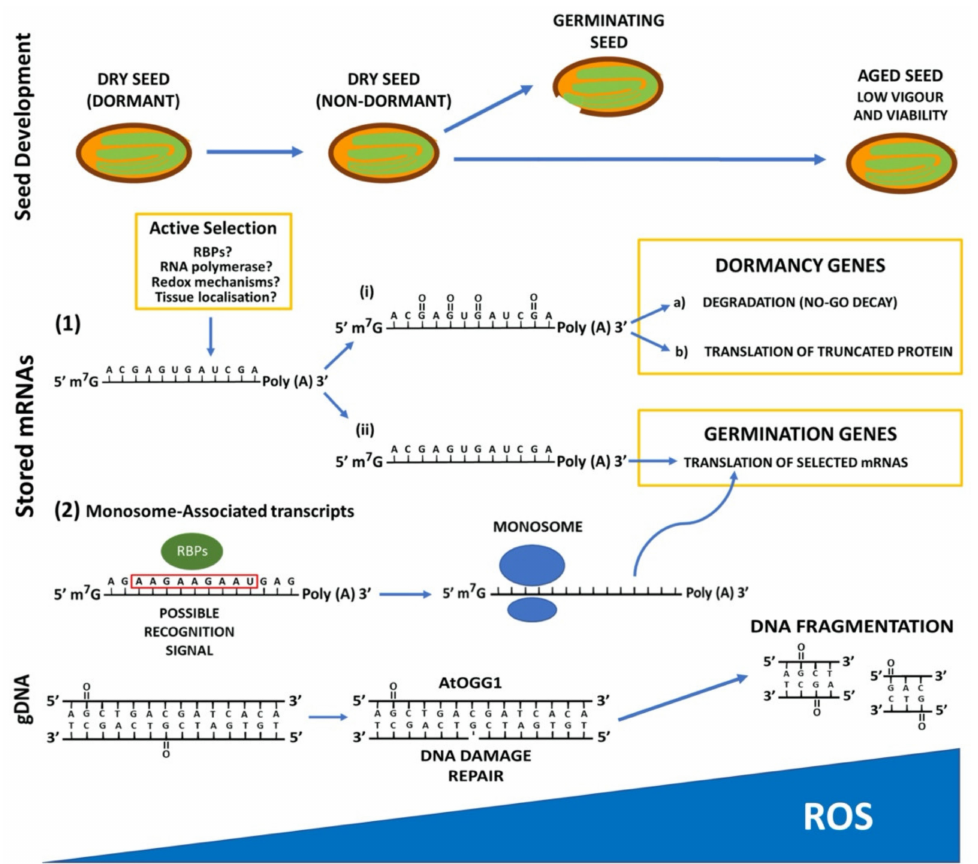
Figure 1. Schematic representation of how reactive oxygen species (ROS) a ff ect seed dormancy and viability by the oxidation of nucleic acids (mRNA and gDNA). Blue circles depict the ribosome. Stored seeds also su ff er DNA damage caused by oxidation, which a ff ects seed